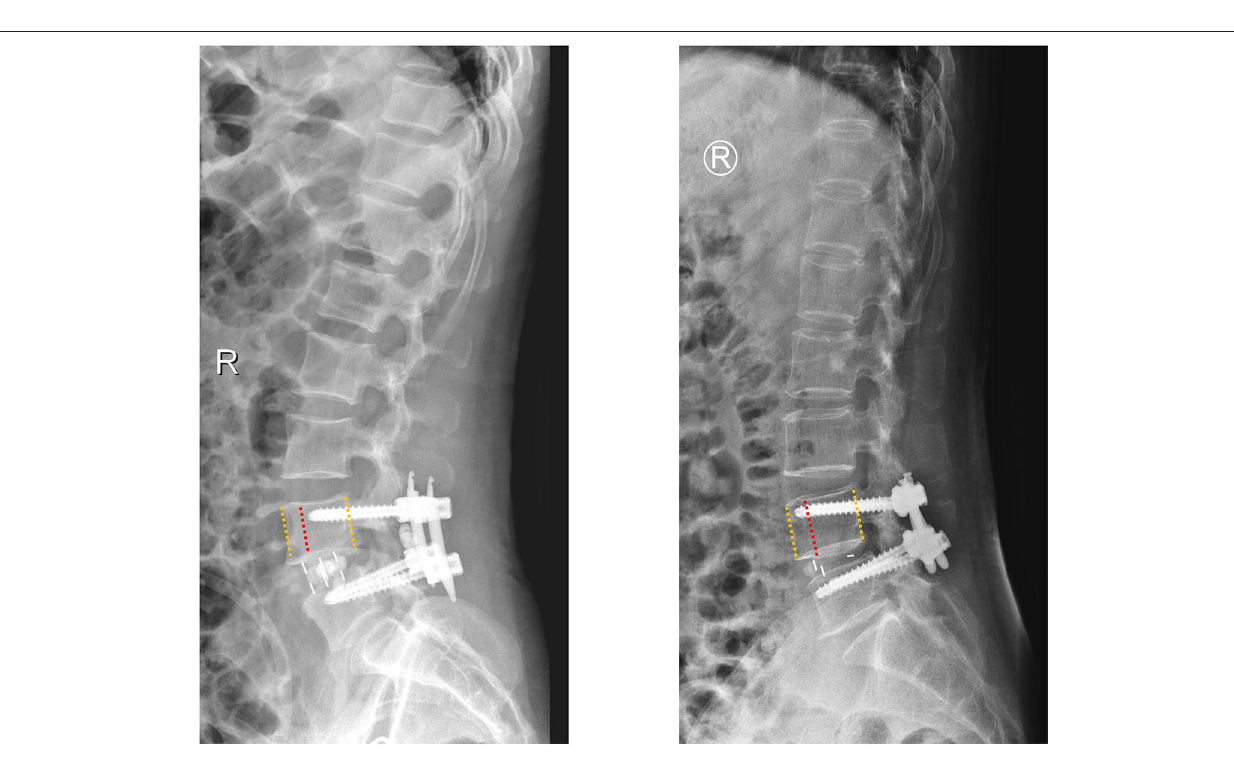
Frontiers in Public Health |